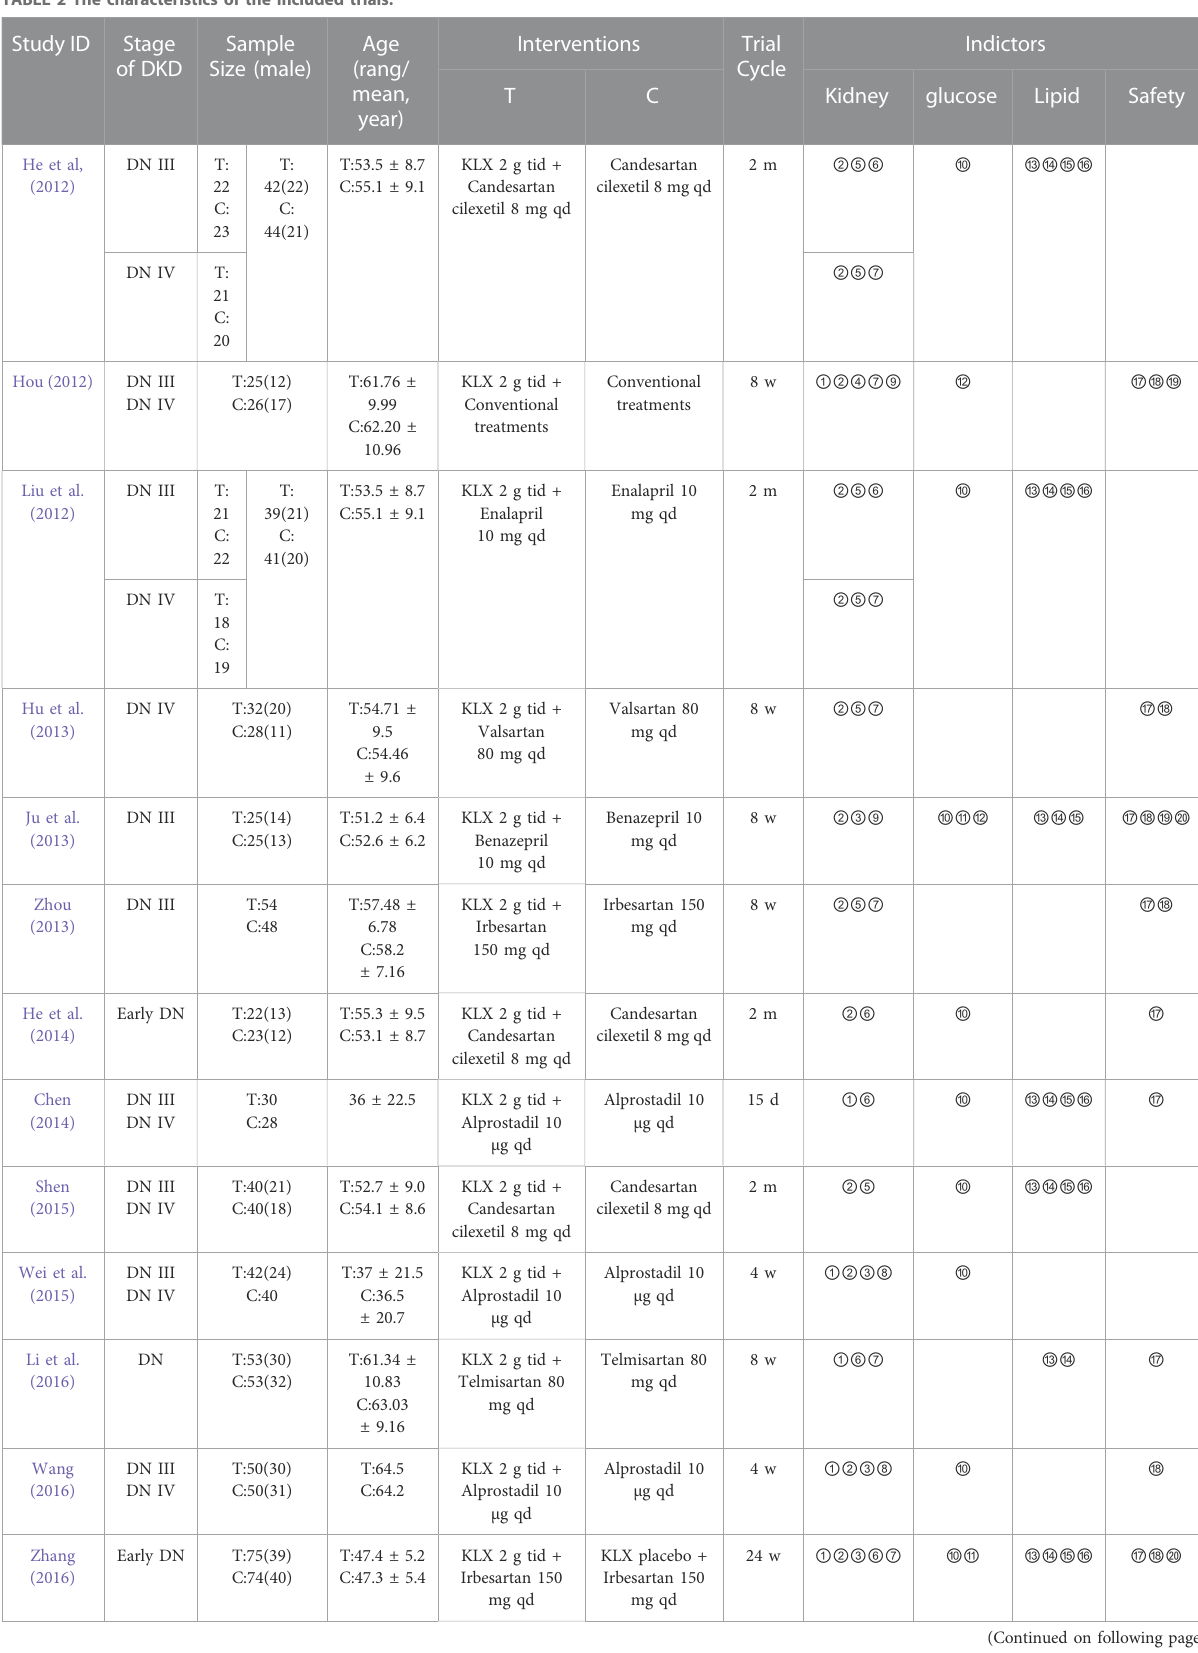
TABLE 2 The characteristics of the included trials. Study